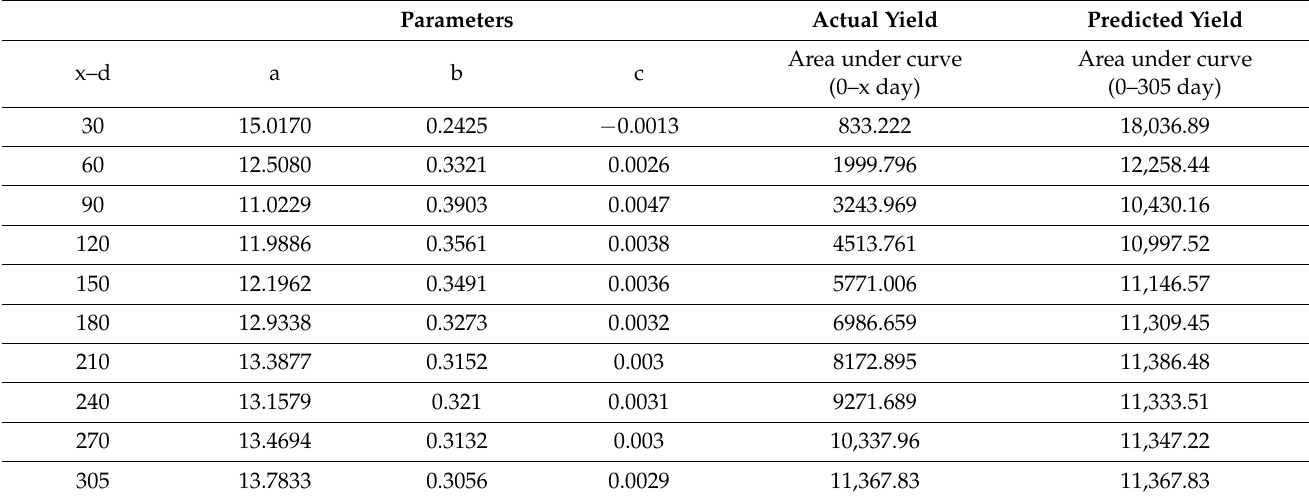
Table 2. Herd T1 Wood function parameters and actual milk yields per x days of milking with predicted yield for 305 days. Parameters